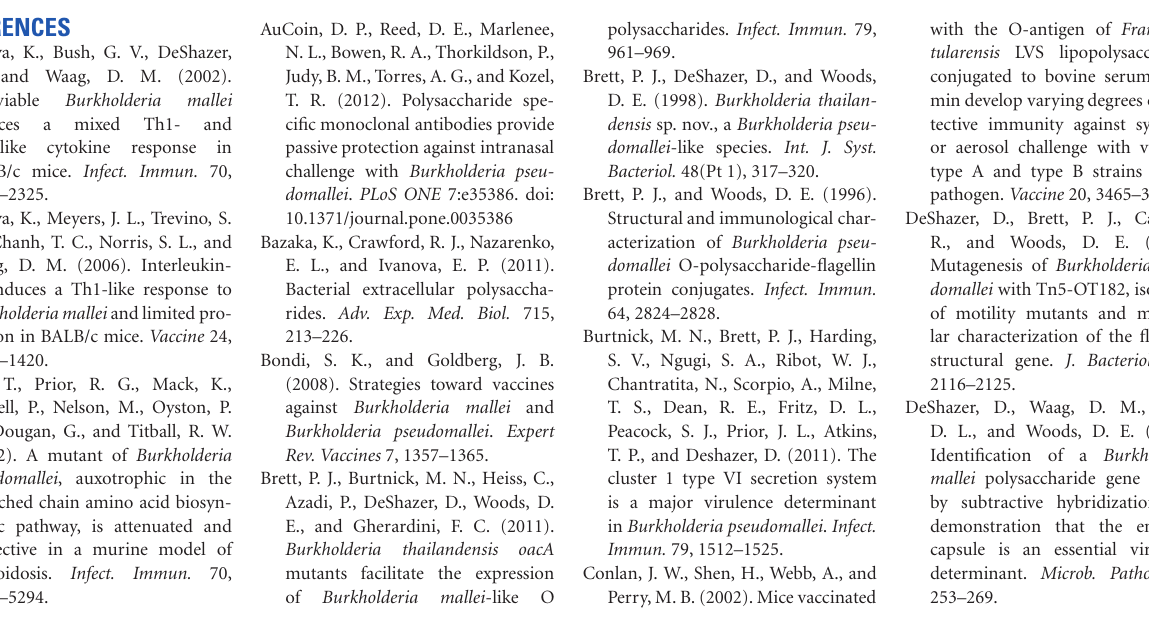
are passively protective in animal models of infection (Jones et